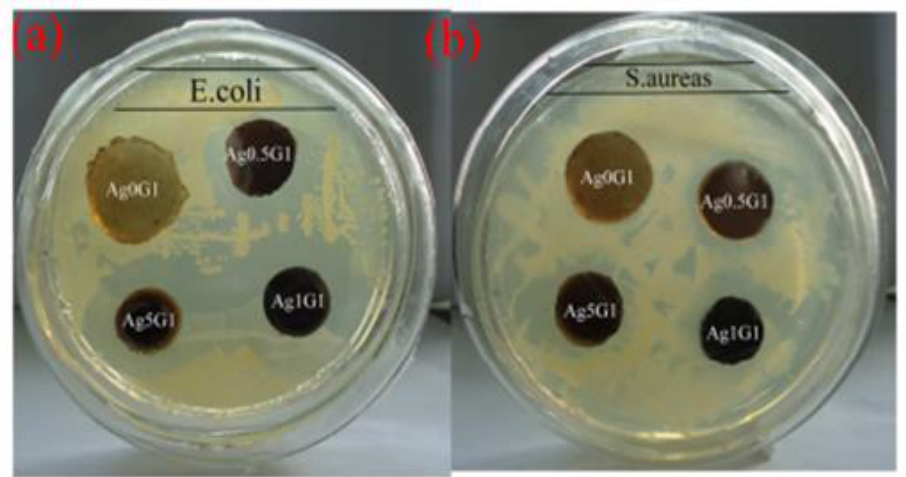
Figure 4. Images demonstrating the antibacterial activity of PNiPAM hydrogels against E. coli ( a ) and S. aureus ( b ). The nanocomposites with different Ag:G mass ratios (0.5:1, 1:1, and 5:1) are named as Ag0.5G1, Ag1G1, and Ag5G1, respectively. Taken from Ref. [58].